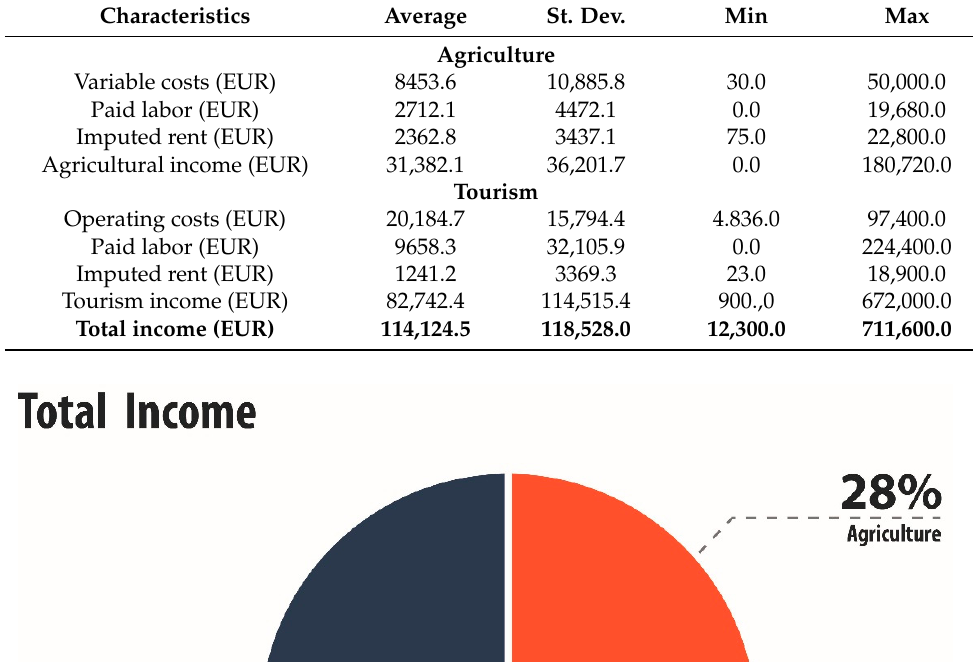
Table 6. Economic Characteristics of Agricultural and Tourism Activities.